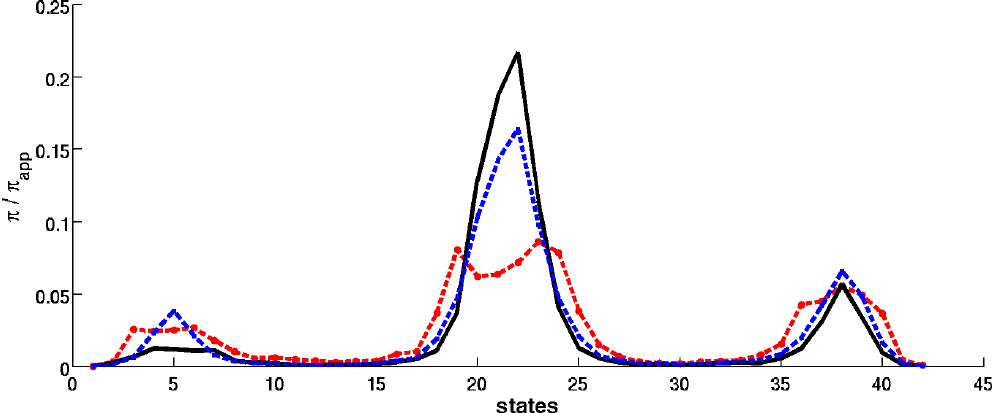
Figure 4: Application of our algorithm to Butane. Left: Mean correlation between the stationary distribution based on a fully pro- vided matrix P and based on a subsampling of a certain percentage of rows of P for Butane. Right: Mean correlation coefficient between the C matrices, fully provided vs. subsampled matrix P of Butane. Each shown mean value and the standard deviations are based on 5 different statistical experiments.